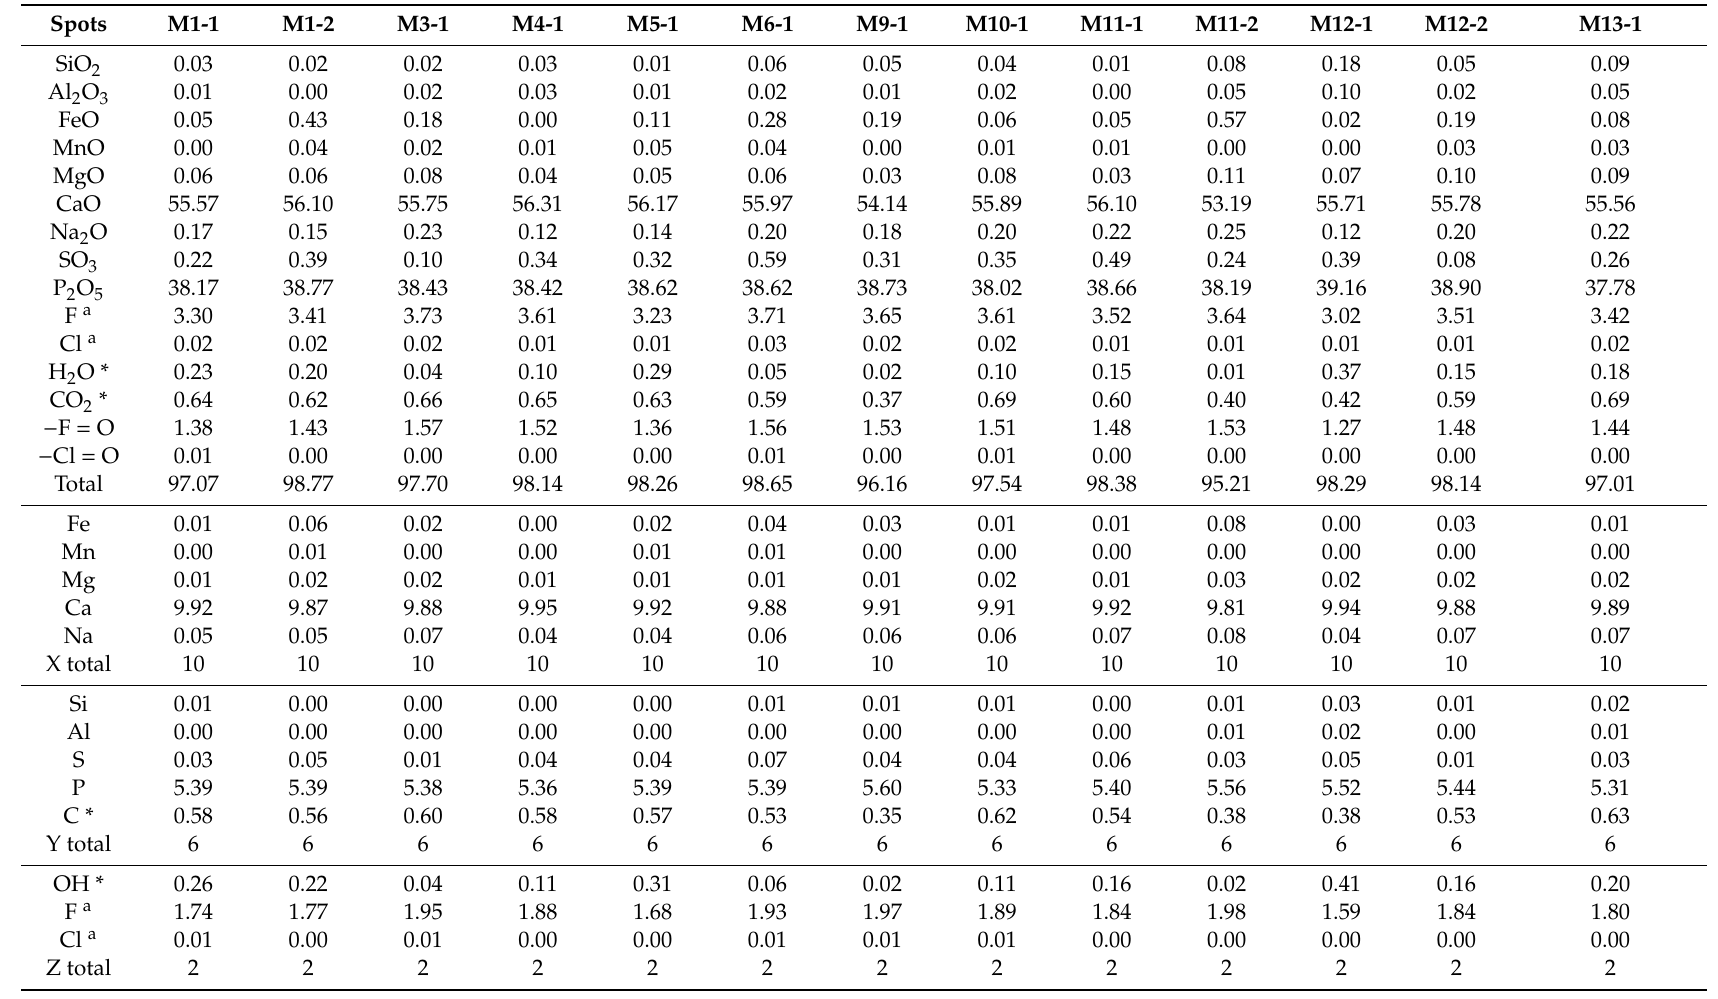
Table 1. Electron probe microanalysis (EPMA) analytical results for apatite grains